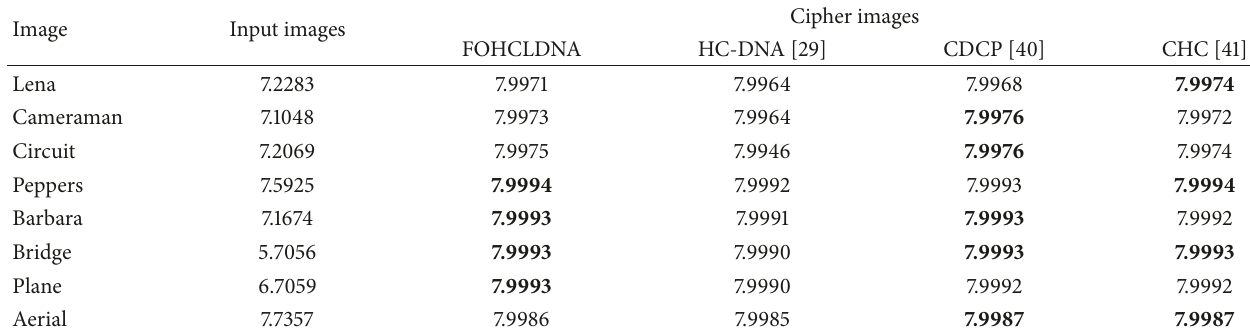
Figure 3: Decrypted images of Lena, Circuit, Peppers, and Plane. The first row is with correct keys: 𝑥 0 1 = 12 , 𝑥 0 2 = 22 , 𝑥 0 3 = 31 , and 𝑥 0 4 = 4 . The second row is with slightly different keys: 𝑥 0 1 = 12 + 10 −15 , 𝑥 0 2 = 22 , 𝑥 0 3 = 31 , and 𝑥 0 4 = 4 . Table 6: The IE of the testing